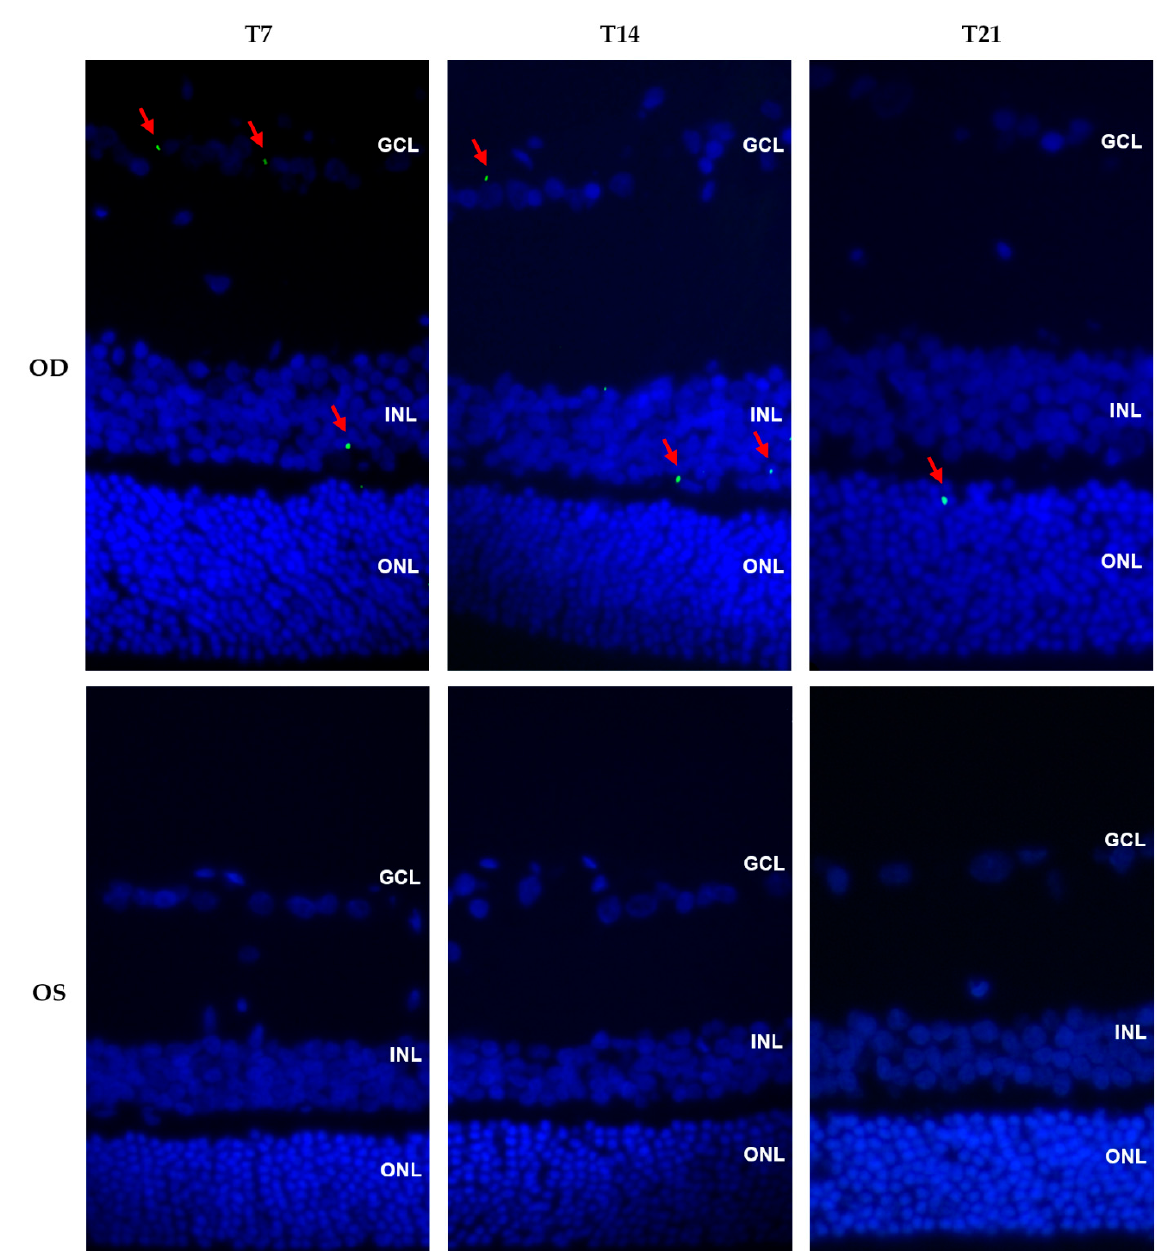
Figure 6. Immunofluorescence photomicrographs showing cross sections of the OD (treated eye) and OS (control eye) in the treatment groups T7, T14, and T21 (magnification 40 × ). Images show the merging of green and blue filters. Red arrows indicate EPO β stained in green and cell nuclei are stained in blue with DAPI. GCL, ganglion cell layer; INL, inner nuclear layer; ONL, outer nuclear layer.